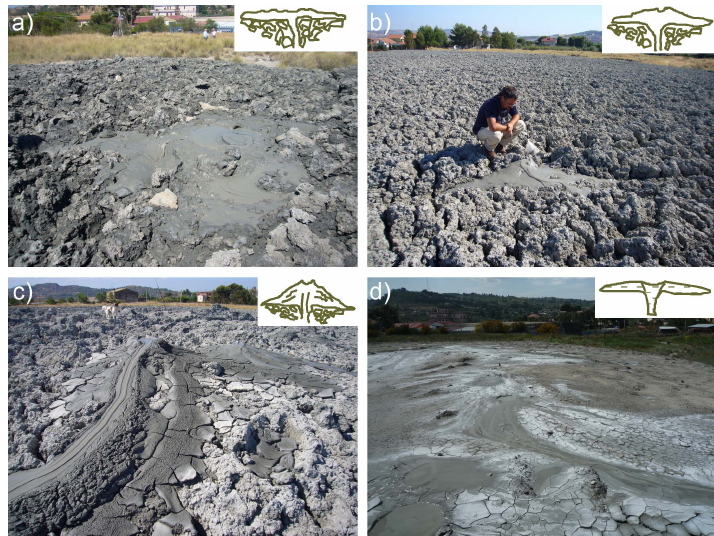
Fig. 6. Field photographs taken at different times illustrating the morphological features of the emitting vents (simplified cross-sections in graphical insets): (a) 13 August 2008; (b) 17 August 2008; (c) 17 September 2008; (d) 26 April 2010.